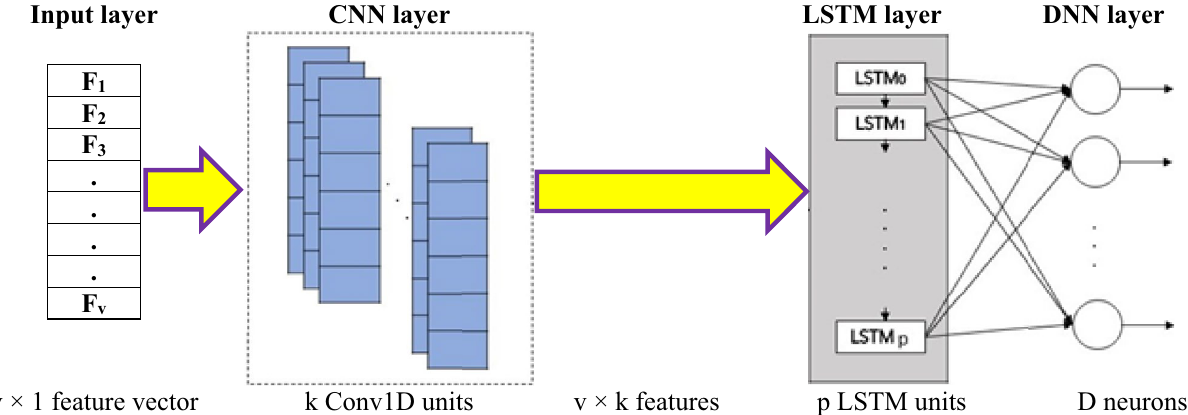
Figure 3. Structure of the hybrid three-layered deep-structured classifier.